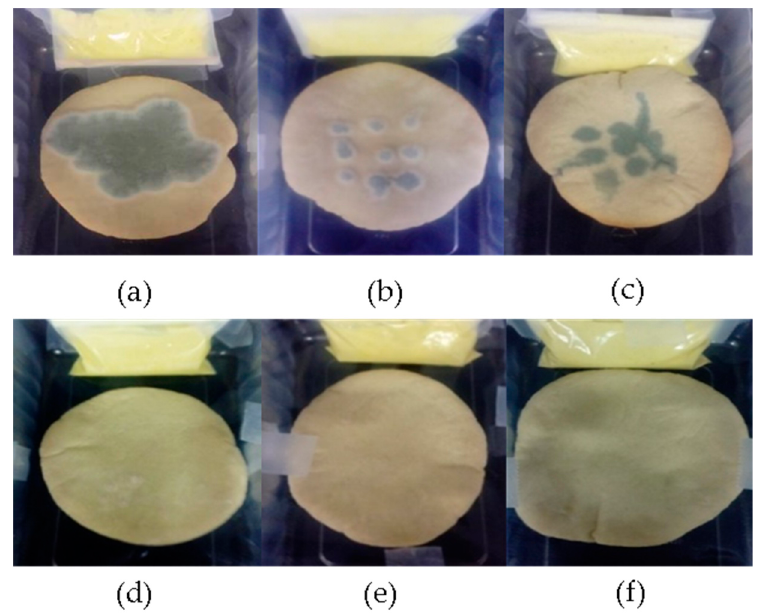
Figure 2. Pita bread inoculated with P. verrucosum and stored during 7 days in a plastic tray containing a small sachet sealed with ( a ) control experiment ( b ) pita bread treated with the preservative compound E-282, ( c ) 8 mg/g, ( d ) 16 mg/g, ( e ) 33 mg/g, and ( f ) 50 mg/g of oriental mustard flour sauce.